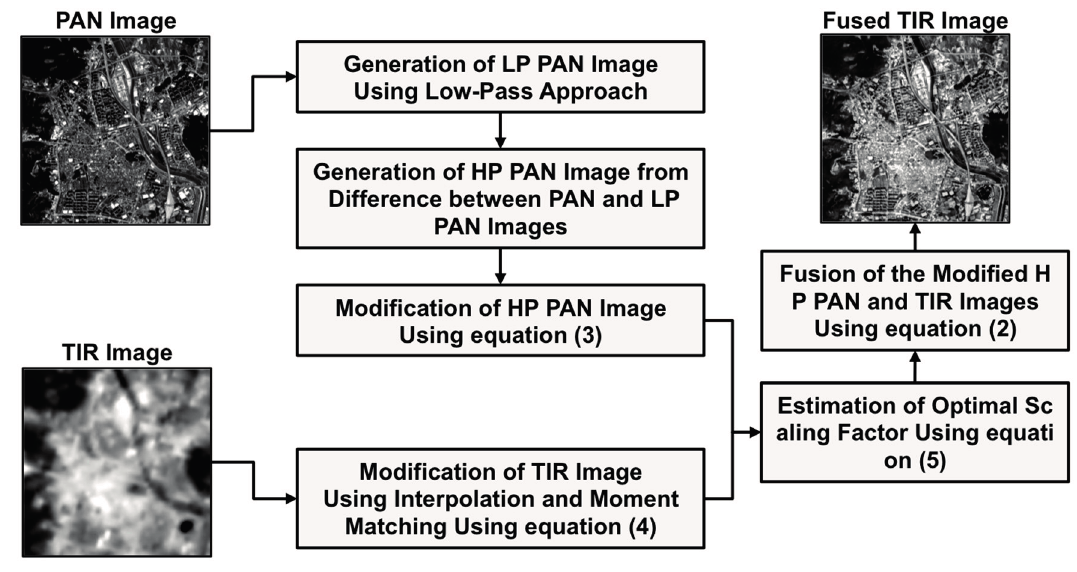
Figure 1. Detailed workflow of the proposed method, where the PAN and TIR stand for panchromatic and thermal infrared,